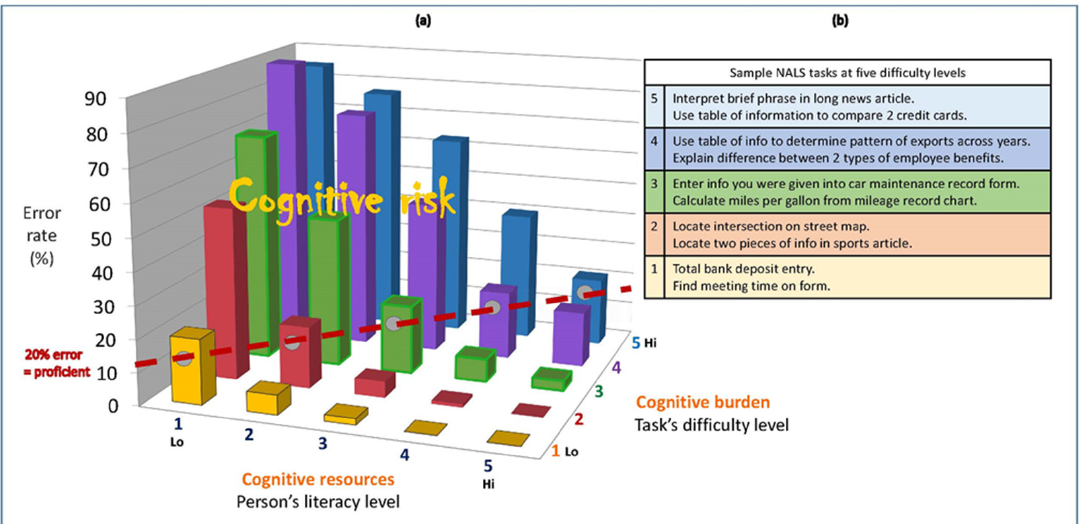
Figure 3. Sample literacy items and landscape of cognitive risk for individuals of lower literacy performing tasks of increasing difficulty. Sources for Panel ( a ), Kirsch et al. (2001, Exhibit 13–36 for document scale); for Panel ( b ), Kirsch et al. ([1993] 2002, Figure 1).